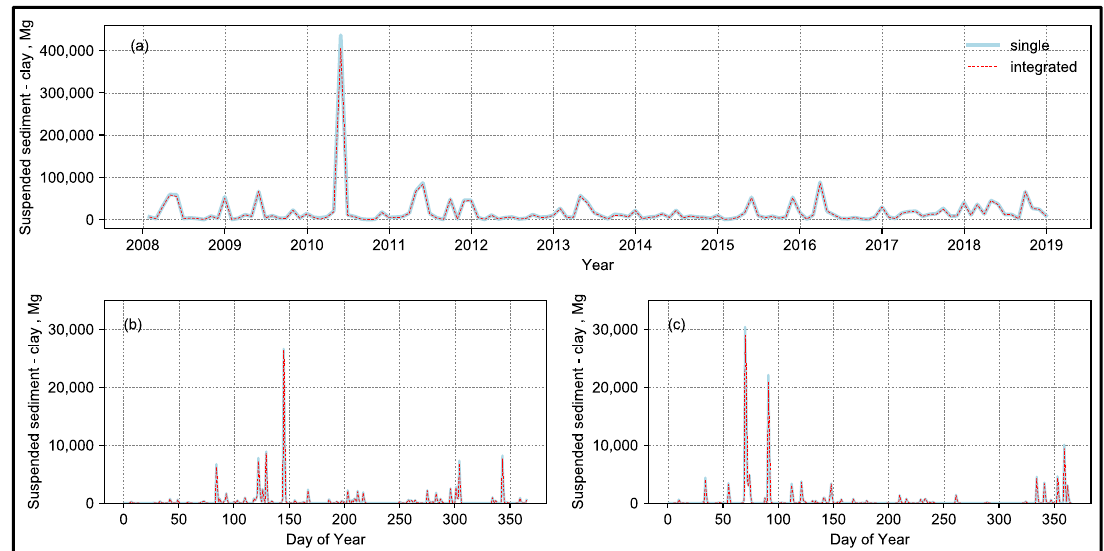
Figure 7. Comparison of suspended sediment loads from single and integrated AnnAGNPS simulations at the watershed outlet at monthly time scale for the entire simulation period ( a ) and at daily time scale for years 2009 ( b ) and 2016 ( c ).